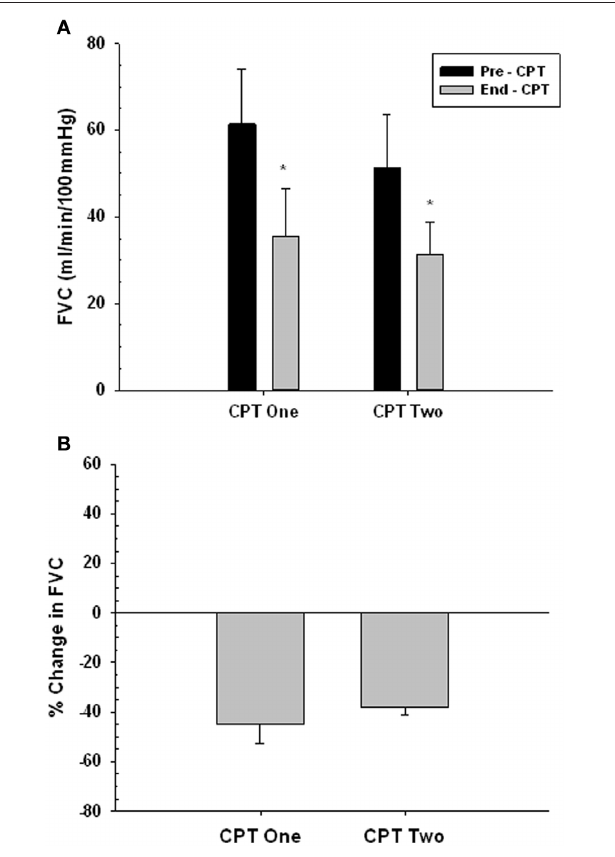
FIGURE 7 | Forearm vasoconstrictor response to CPT during repeated trials at rest. CPT 1—first CPT test. CPT 2—second CPT test. Panel (A) forearm vascular conductance (FVC) before (Pre-CPT) and at the end of (End-CPT) a CPT. Panel (B) The difference in Pre- vs. End-CPT FVC expressed as %change. ∗ Main effect, significantly different from Pre-CPT, P = 0 .